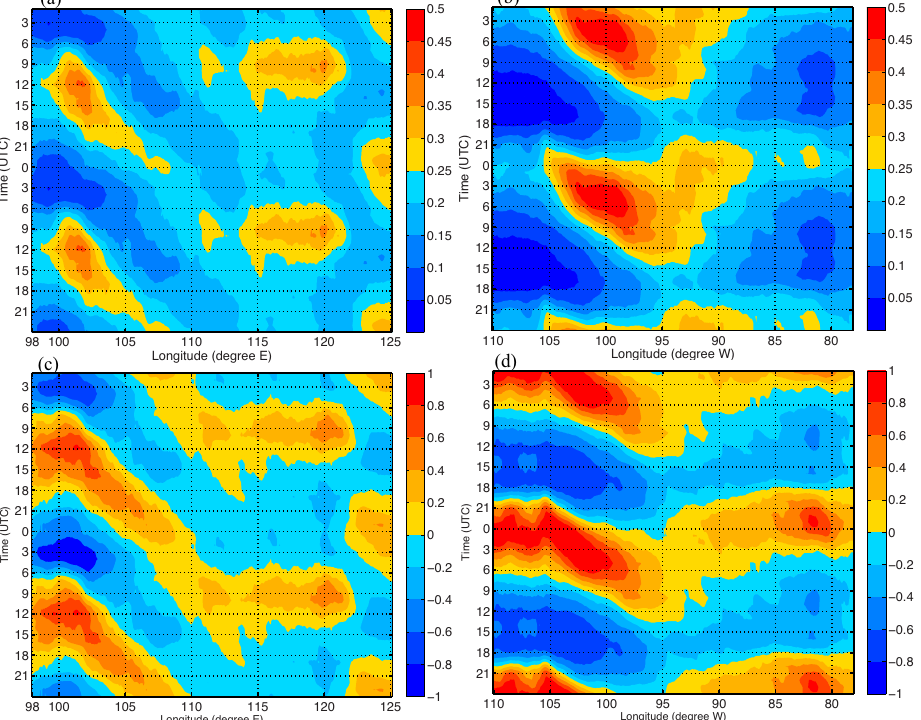
Figure 2. Top: Time–longitude diagrams of the warm-season hourly mean precipitation (units: mmh − 1 ) over the focus domains for (a) East Asia and (b) North America. Bottom: time longitude diagrams of the warm-season normalized hourly mean precipitation averaged meridionally over the focus domains for (c) East Asia and (d) North America.